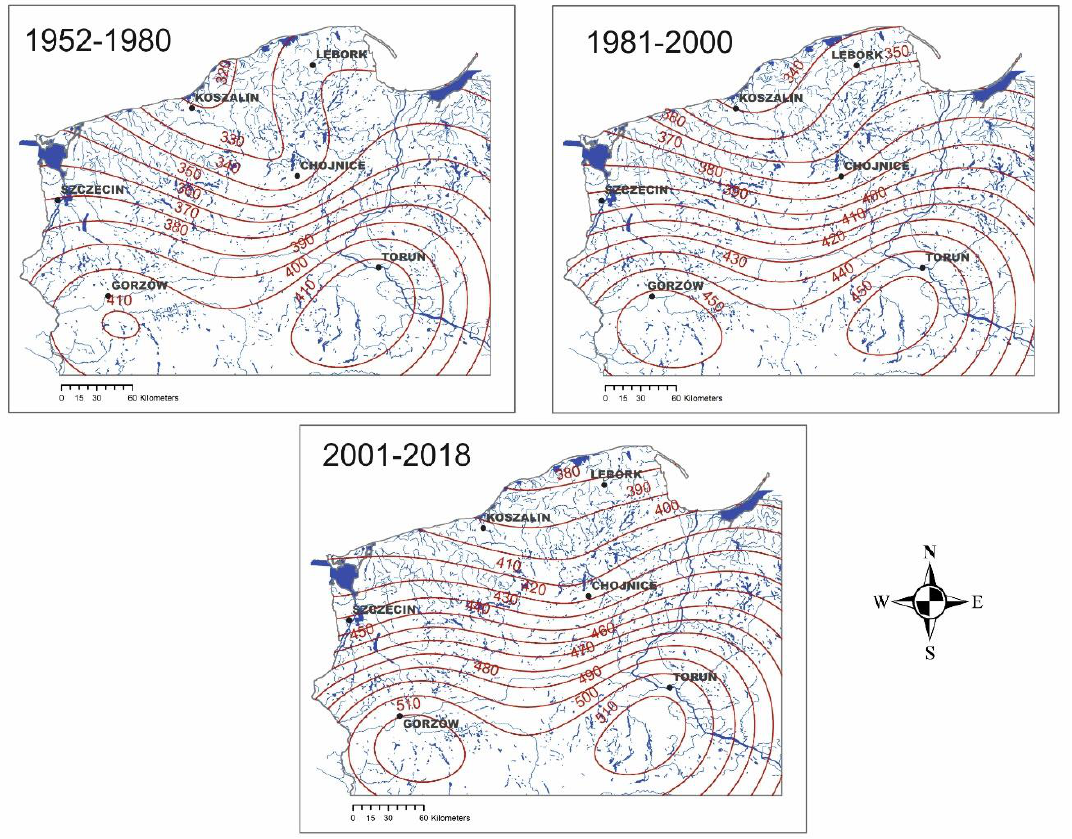
Figure 7. Spatial distribution of average summer half-year (V–X) sums of potential evaporation in north-western Poland divided into the periods 1952–1980, 1981–2000 and 2001–2018 against the distribution of the water network (calculated based on data obtained from the Polish Institute of Meteorology and Water Management—National Research Institute [43], water network based on [41]). In the winter half-year (XI–IX), evaporation in the periods 1952–1980 and 1981–2000 decreased with distance from the shore, as well as eastwards, though the change is not high, not exceeding 30 mm (Figure 8). The last period, 2001–2018, is characterised by a di ff erent spatial pattern of evaporation distribution. The evaporation values were highest (160 mm) in the western part of the study area and decreased eastwards to 80 mm. Apart from the trend of increasing evaporation in the study area in the subsequent periods, the spatial distribution of evaporation is also indicative of evaporation conditions between the east and west of the study area being more diverse in the years 2000–2018 than in the preceding